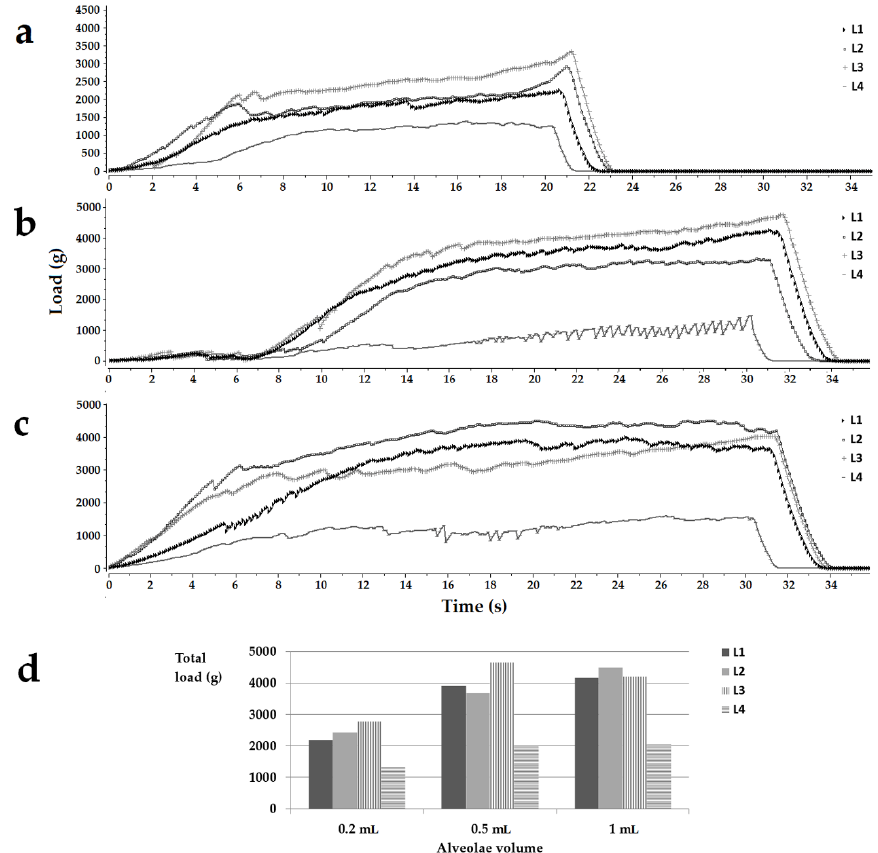
Figure 1. Load (g) vs. time(s) texture analysis representative profiles for the placebo OLs obtained in 0.2 mL ( a ), 0.5 mL ( b ), and 1 mL ( c ) alveolae and a histogram summarizing the total load of the samples ( d ). Legend: L1, L2, L3, L4, the type of milk. In the case of samples poured into 0.2 mL alveolae, the hardness decreased in the following order L3> L2 > L1 > L4. For the 0.5 mL cakes, the highest hardness was obtained for the L3 samples, followed by L1, L2, and L4. In the case of samples with a volume of 1 mL, L2 milk led to the most resistant structures, followed by L1, L3, and L4 (Figure 1d).